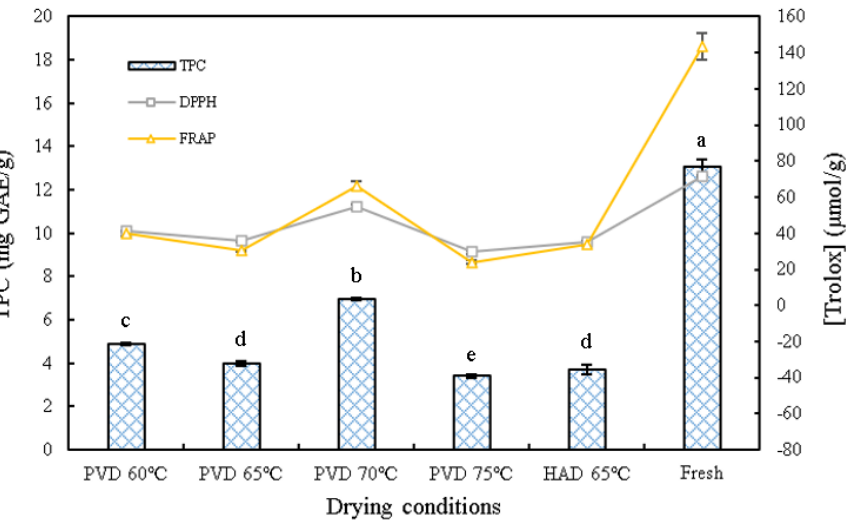
Figure 7. The total phenolic content (TPC), DPPH, and FRAP values of dried persimmon slices at different drying conditions. PVD: pulsed vacuum drying (12:4 min). HAD: hot air drying. The different letters, a, b, c, d, and e, reveal significant differences ( p < 0.05) according to the Duncan test.